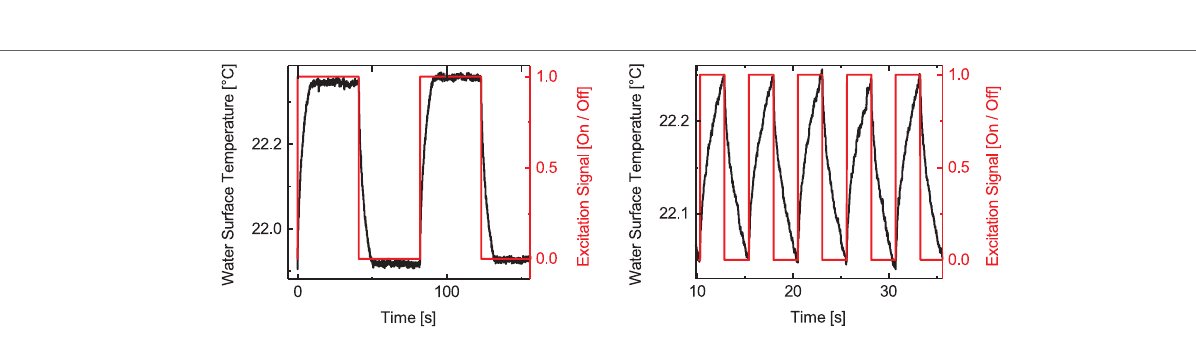
FigURe 5 | Actual data of a heating process as seen from above. Shown is the doubled temperature amplitude obtained for a very low excitation frequency of 0.012 Hz and for a wind speed of 1.2 m/s in the Heidelberg wind-wave facility Aeolotron. The left figure shows the heated area, and the right figure shows the temperature amplitude profile along the red line from the left figure.